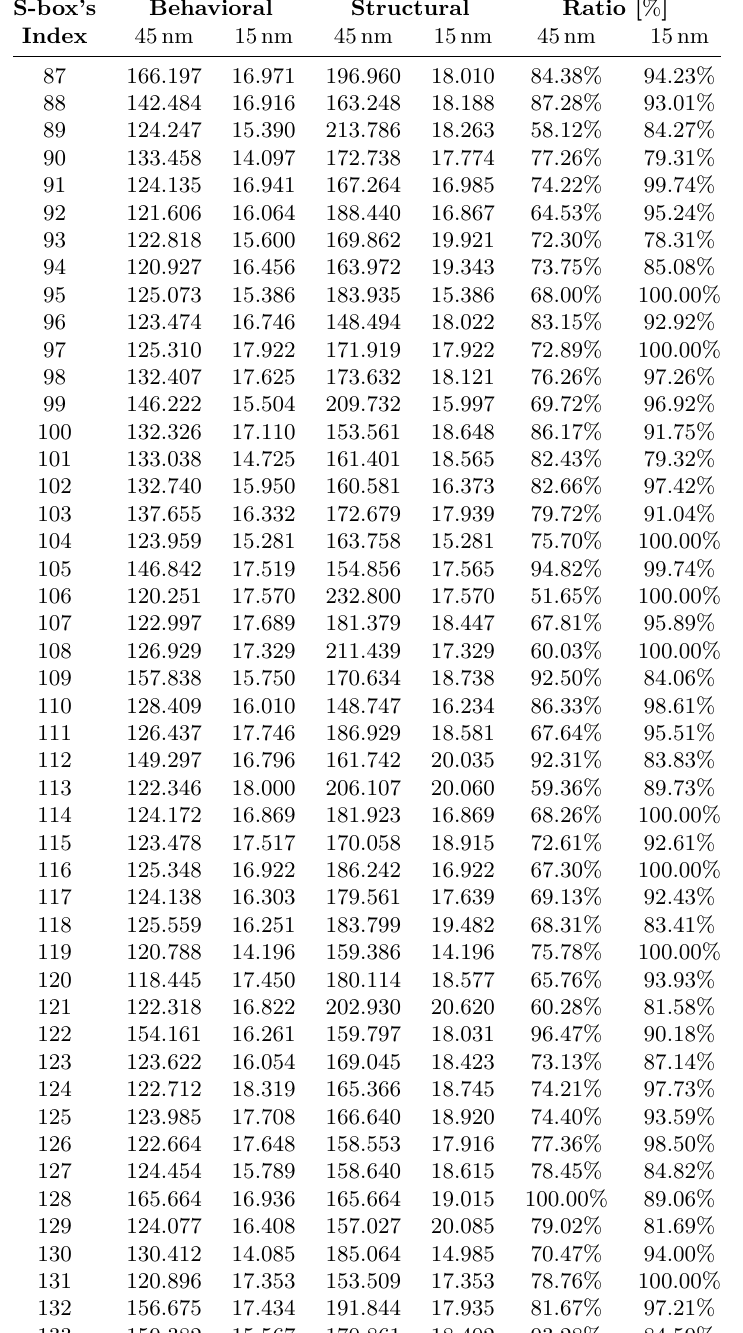
Table 8: Latency of the circuits for 7-bit quadratic S-boxes used in Example 5 using behavioral and structural modes of implementation in NanGate 15 nm and 45 nm